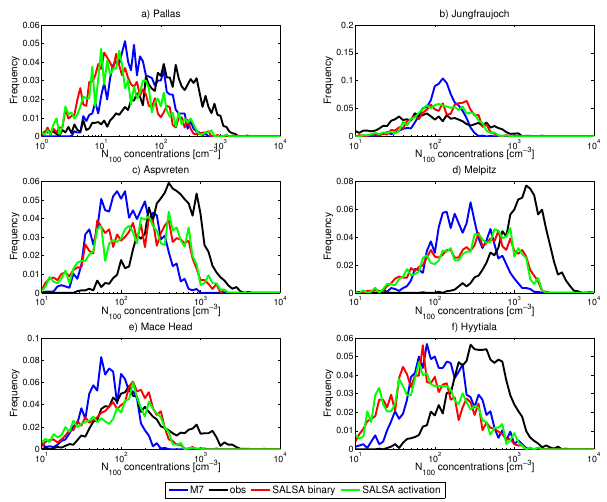
Fig. 6. Histograms of N 100 concentrations at six EUCAARI stations. The concentration bins are evenly distributed in the logarithmic concentration axes. Y-axis shows the relative fraction of each bin compared to total number of valid measurements.